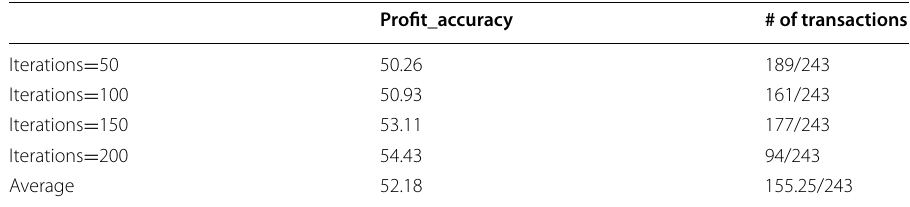
Table 5 TI_LSTM model: one‑day‑ahead result summary